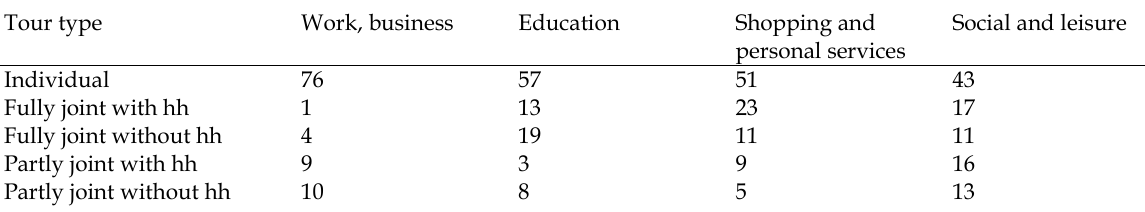
Table 5. Distribution of joint tours (%) by purpose in 2014